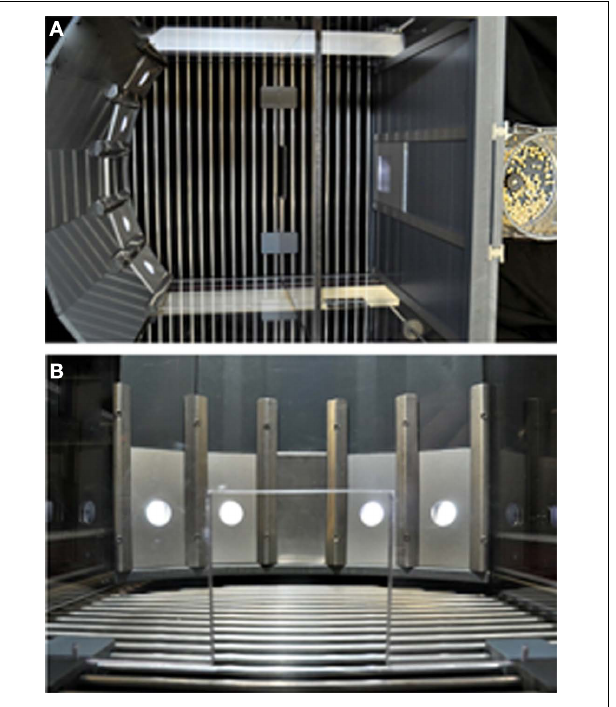
FIGURE 4 |The four-hole operant chamber model (RGT onesessionrewardandtime-out ). (A) Top view of the apparatus (Imetronic).These chambers are modular and can be configured for multiple behavioral paradigms (one or several nose-poke or levers, drug self-administration). A transparent vertical partition containing a central opening divides